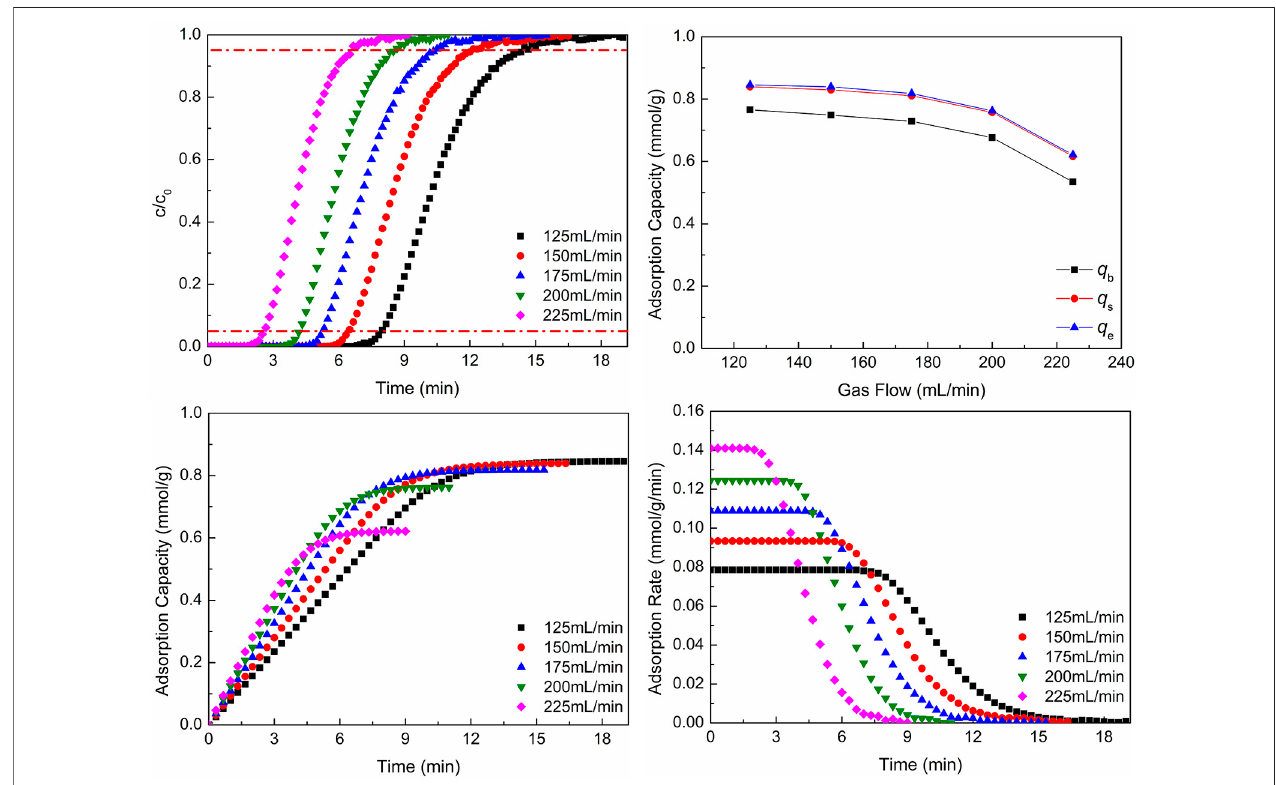
FIGURE 5 | CO 2 adsorption properties at different gas fl ows: (A) breakthrough curves; (B) adsorption capacity; (C) adsorption process; (D) adsorption rate.